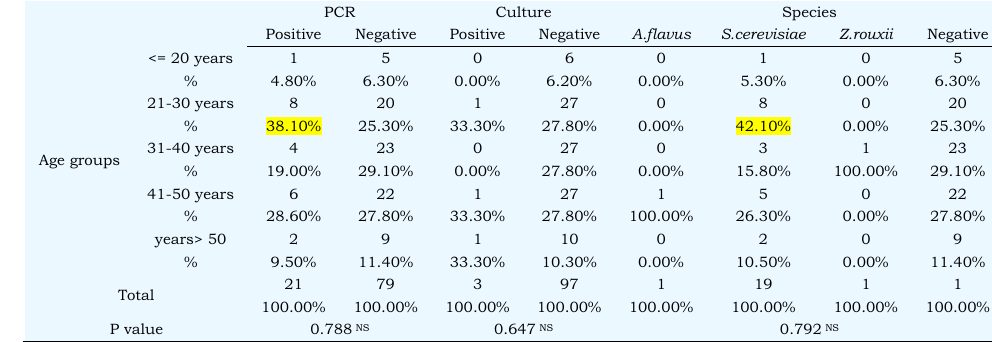
Table 5 Frequency of fungemia among renal transplant recipients according to age groups by conventional and molecular methods